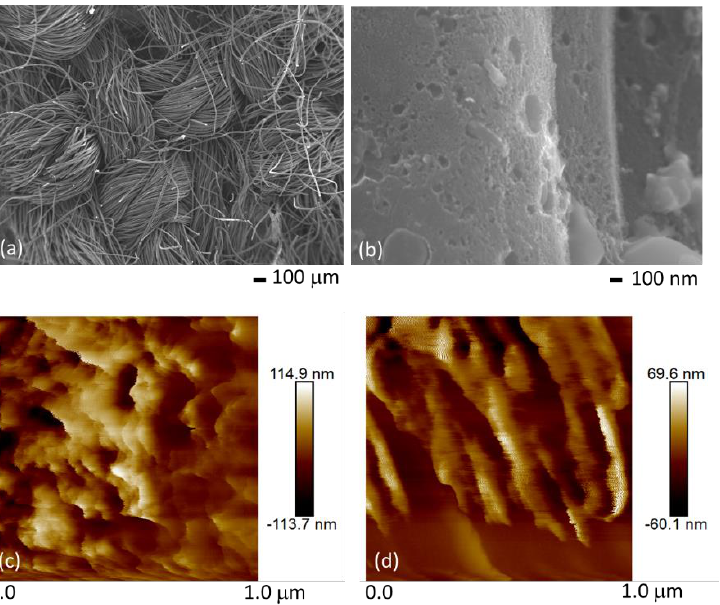
Figure 1. SEM images ( a , b ) and AFM images ( c , d ) of the surface of the activated carbon fabric (ACF) electrode.